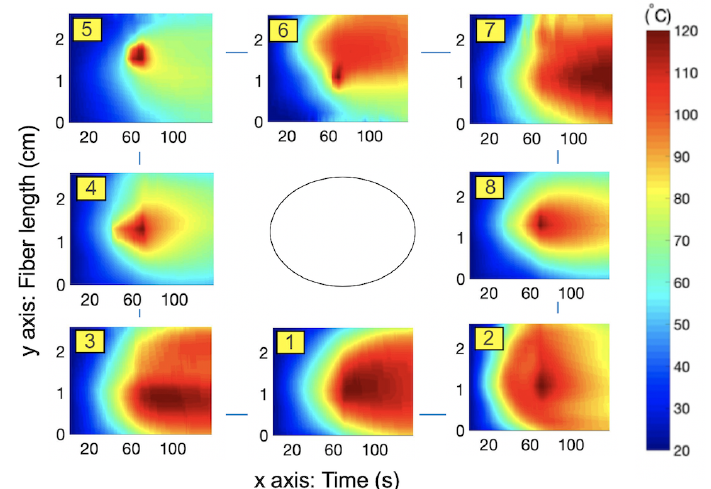
Figure 3. Temperature maps for the 9–12 fibers located closest to the applicator.